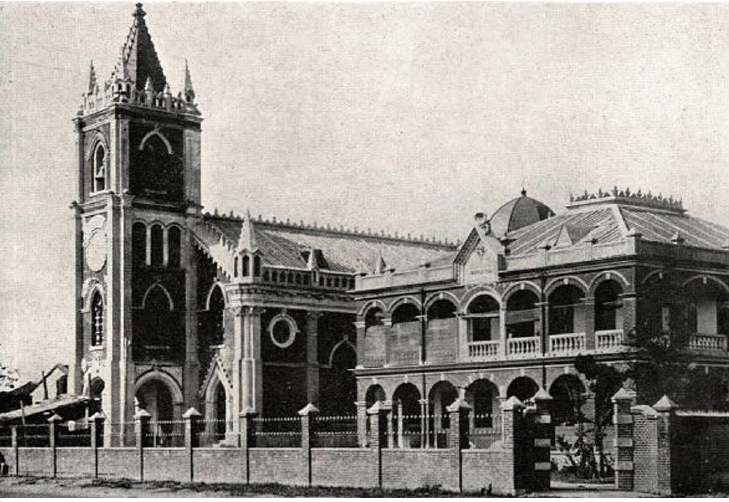
Figure 7. Immaculate Conception Cathedral 聖 母 無 原 罪 主 教 座 堂 , Taipei. During World War II, the church was bombed in 1945 and then replaced with a simpler